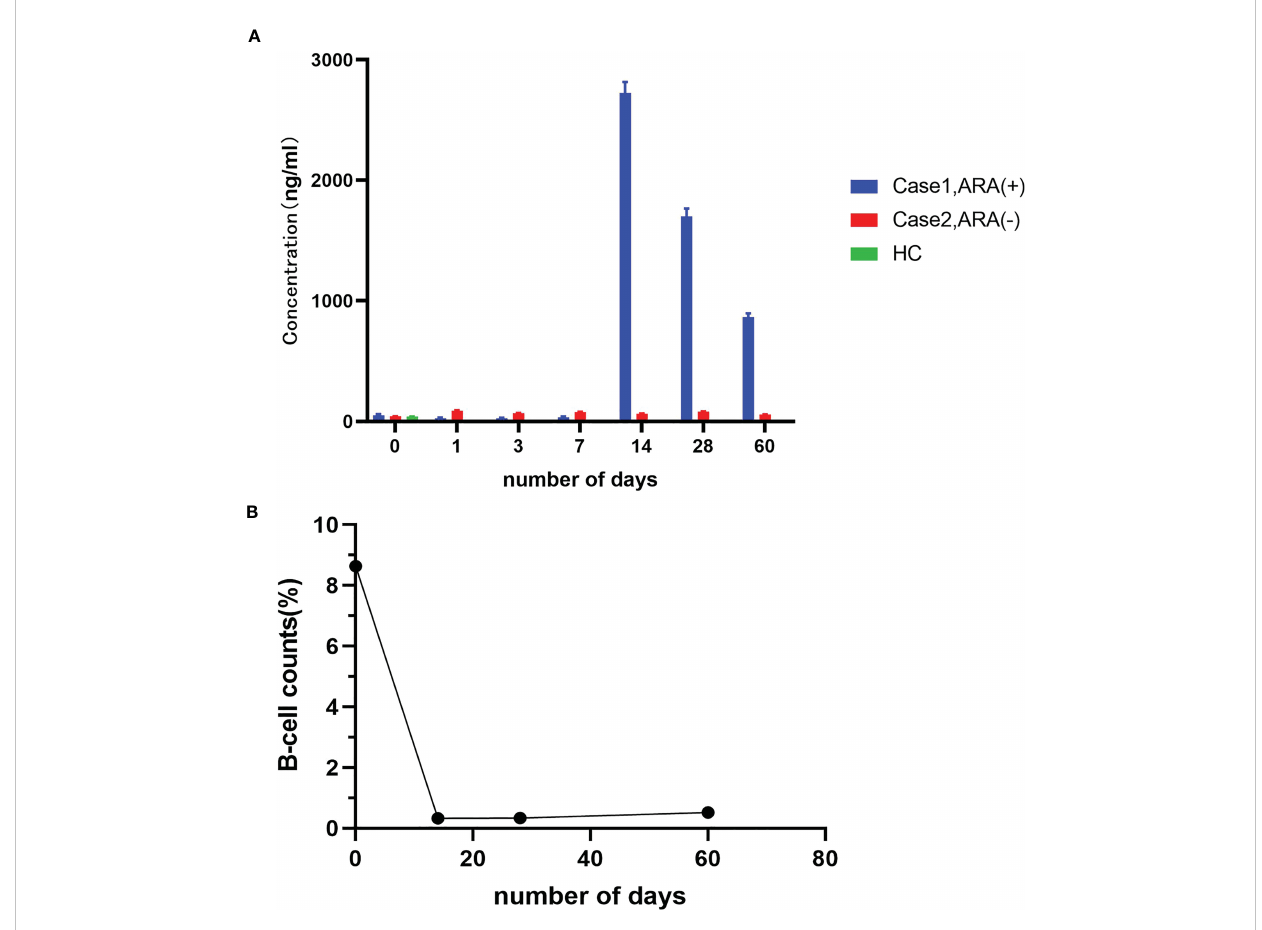
FIGURE 3 Detection of ARAs and peripheral CD19 + B-cell counts. (A) ARAs in case 1 and case 2 at admission and on days 1, 3, 7, 14, 28, and 60 after the fi nal round of rituximab infusion; (B) Peripheral CD19 + B-cell counts in case 1 at admission and on day 1, 3, 7, 14, 28, and 60 after the fi nal round of rituximab